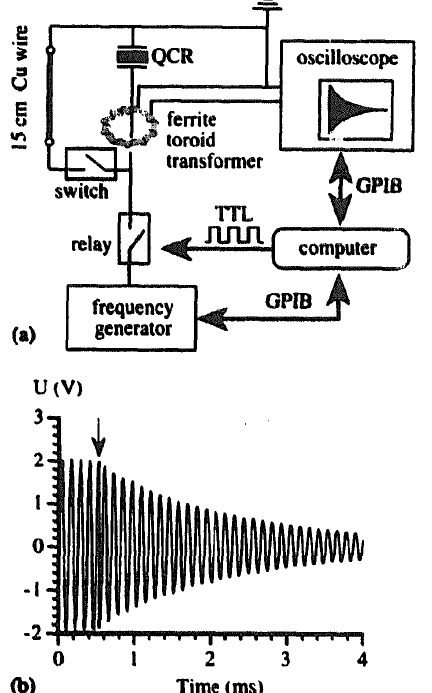
Figure 18. Circuit block diagram: ( a ) Schematic diagram. ( b ) Circuit diagram in detail. Reprinted from Sensors and Actuators B: Chemical, 37, Rodahl M. and Kasemo B., Frequency and dissipation- factor responses to localized liquid deposits on a QCM electrode, 111–116, (1996), with permission from Elsevier [62].